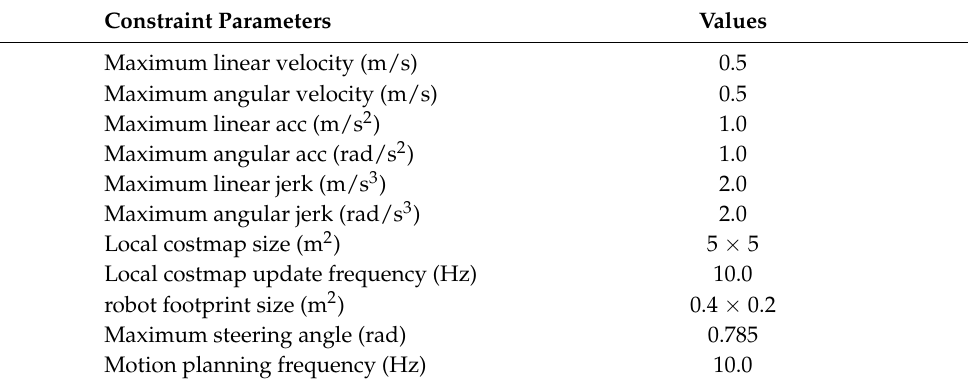
Figure 11. The simulation environment. The green curve represents the global path recorded in advance. The red curve with arrows represents the motion trajectory and the blue arrow indicates the local target. Table 2. Simulation Parameters.